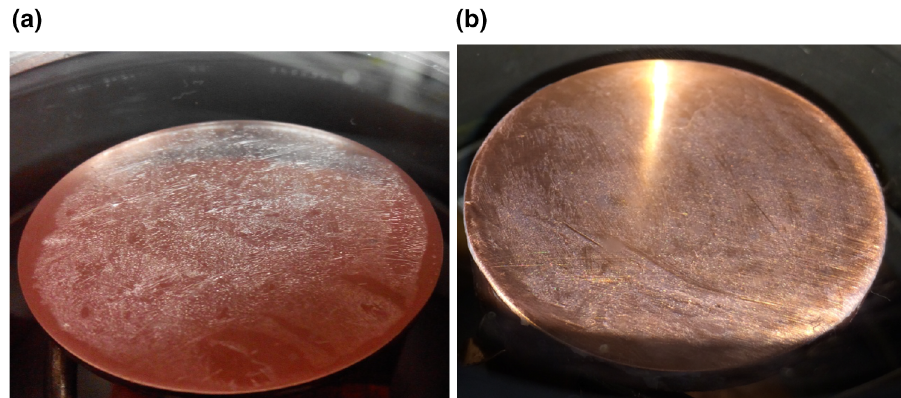
Fig. 5 a A layer of F-2800 oil at a temperature of 140 K, b a layer of lubricant U-18 at a temperature of 120